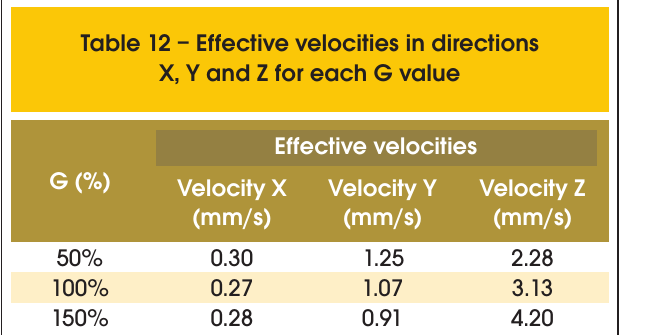
Table 12 – Effective velocities in directions X, Y and Z for each G